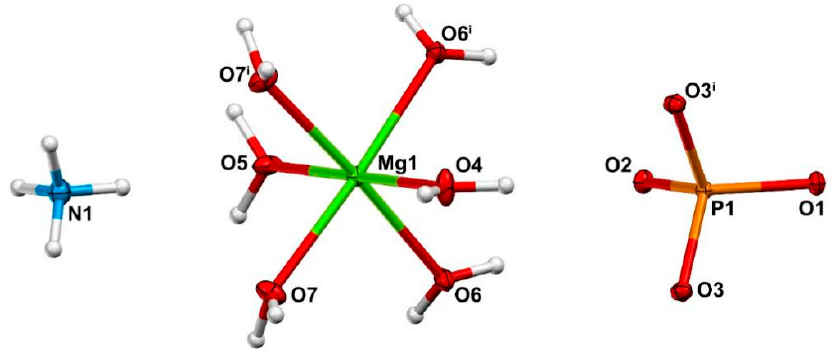
Figure 3. A view of the molecular structure of struvite with the atom numbering scheme. Symmetry code: (i) − x,y,z. Atomic displacement ellipsoids are drawn at 50% probability level. Hydrogen atoms are shown as small white spheres of arbitrary radius.